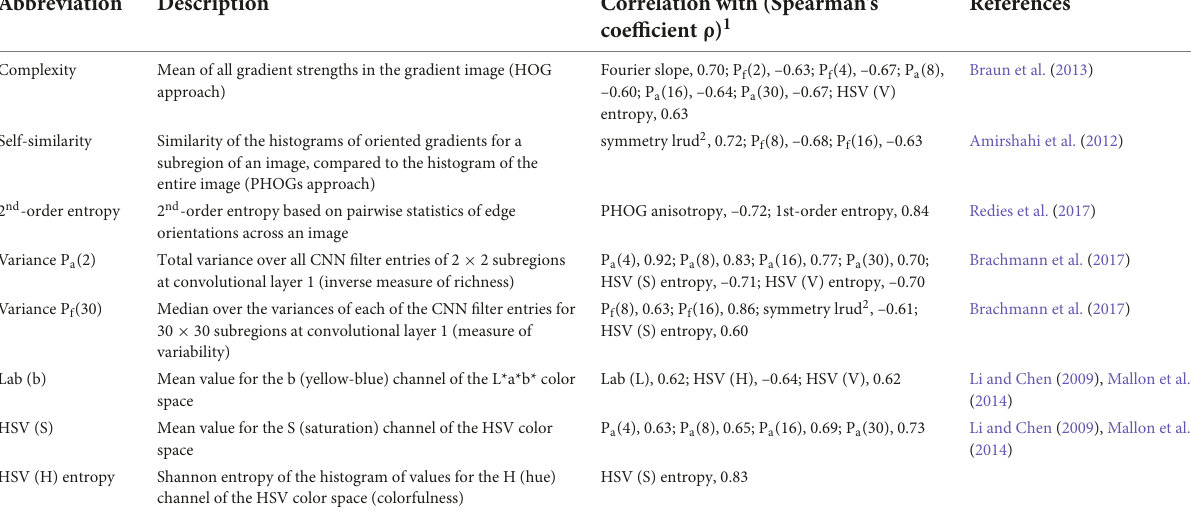
TABLE 1 Statistical image properties used in the analysis.